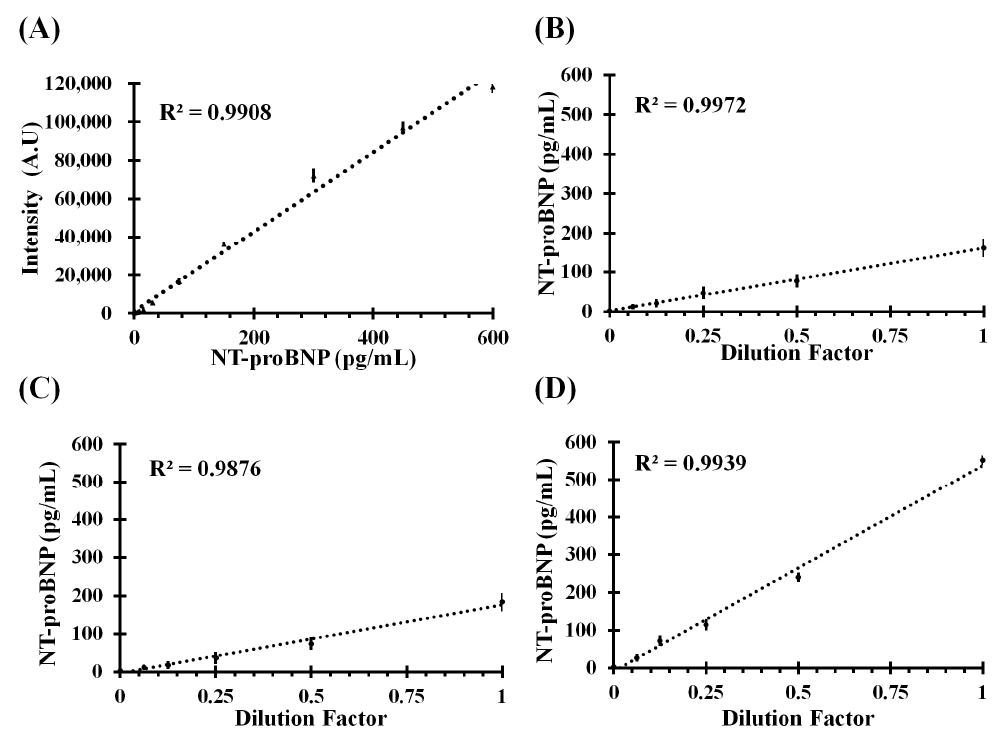
Figure 1. ( A ) Standard curve, ( B – D ) depict the linearity of the test in clinical samples containing 162 pg/mL, 183.3 pg/mL, and 551.9 pg/mL of NT-proBNP after spiking,